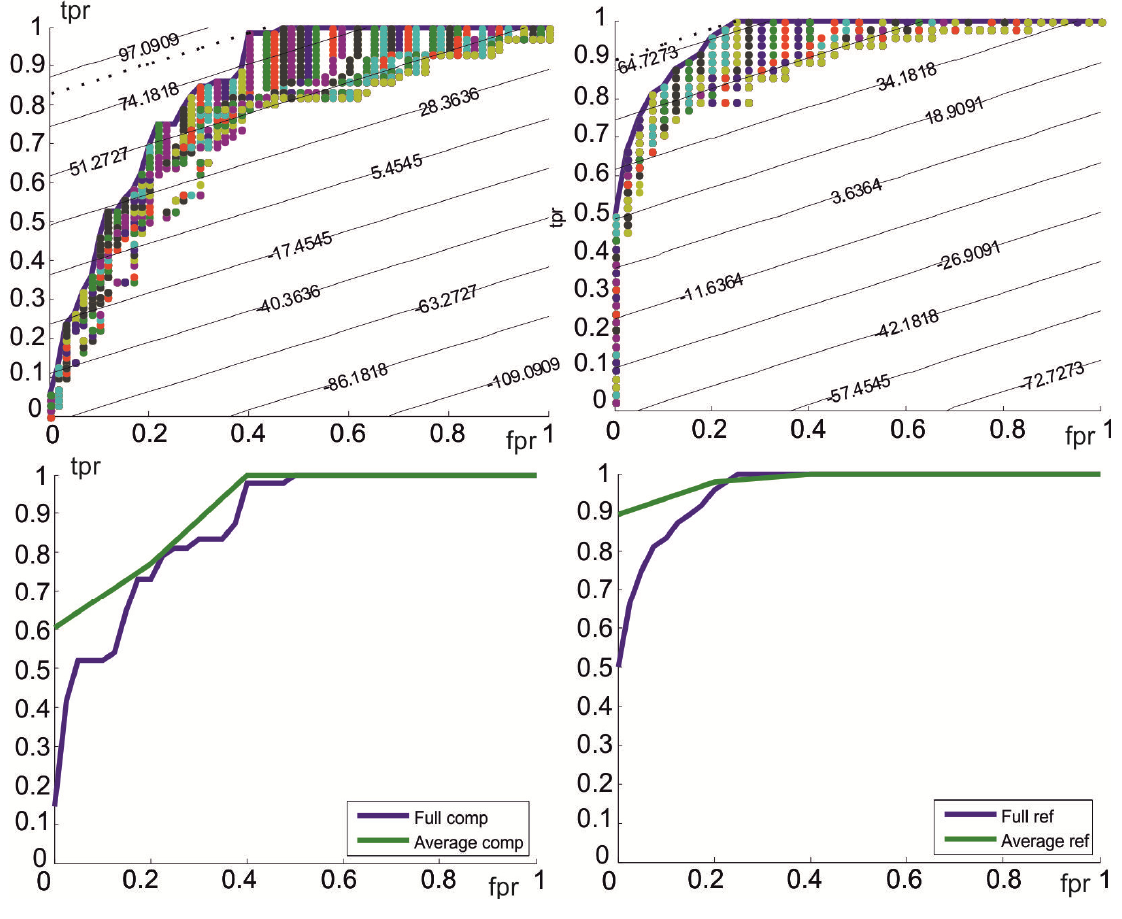
Figure 2. Top row: enveloping curves of ROC points associated with impact detection in the isotropic algorithm (Equation (1) with 4 axes) for the study carried out using 12 subjects with 1 set ( left ), and over the subject with 8 sets of activities ( right ). Bottom row: average of enveloping curves of ROC points obtained for each set (AUC ROC for all activities. Left: the full ROC is presented for a representative combination of 8 sets from the study with 12 subjects with 1 set. Right: the full ROC refers to the total 8 sets from the study over 1 subject with 8